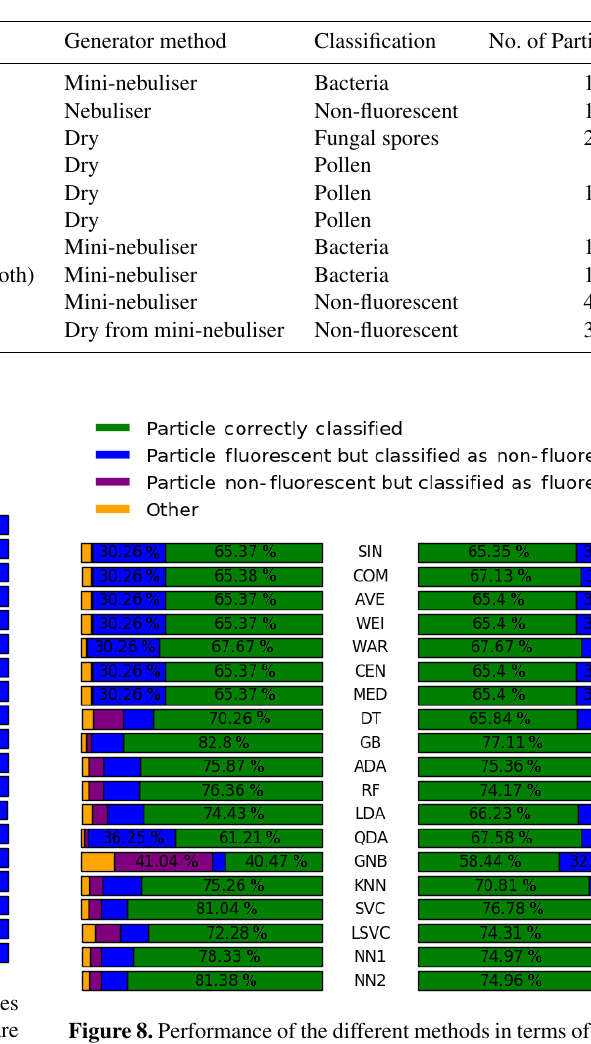
Table 2. Classification, generator method and sample size of different samples from the laboratory data.